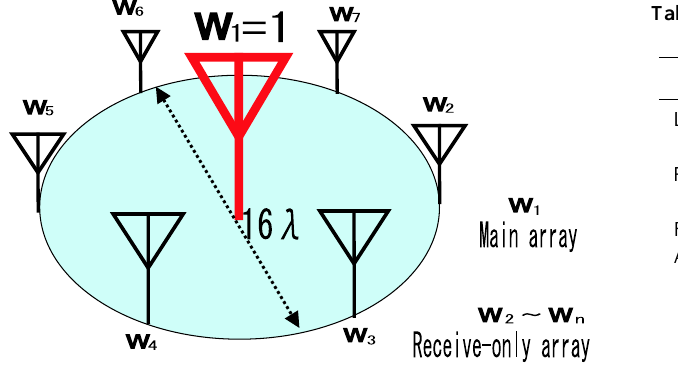
Fig. 1. Configuration of a high-gain antenna with a peripheral receive-only sub-array.